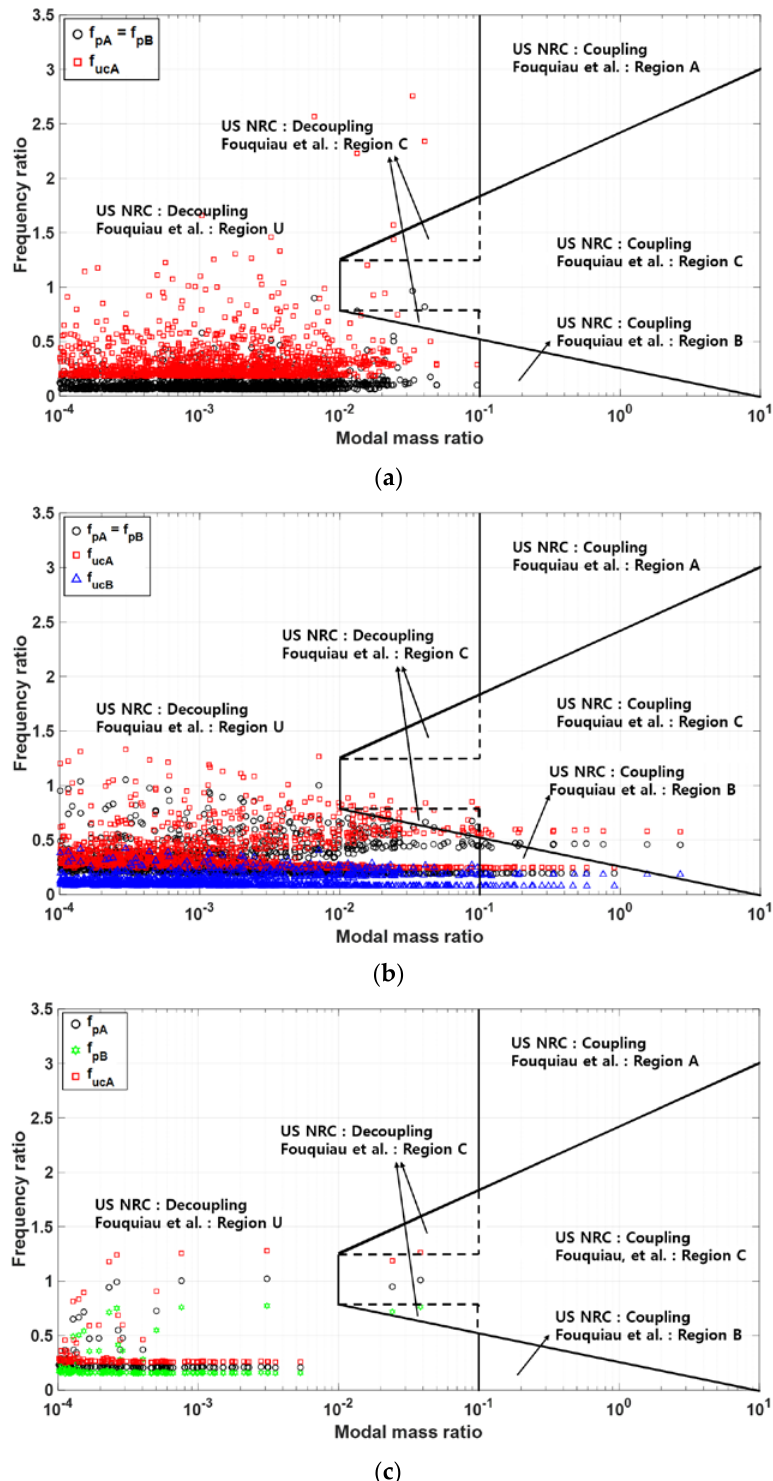
Figure 21. Application of Decoupled Analysis Criteria (Model A): ( a ) Equipment Location 1 (H2 direction, ( b ) Equipment Location 2 (V direction, (V direction, 𝜇𝜇 = 1.0%); 𝜇𝜇 = 0.001%).